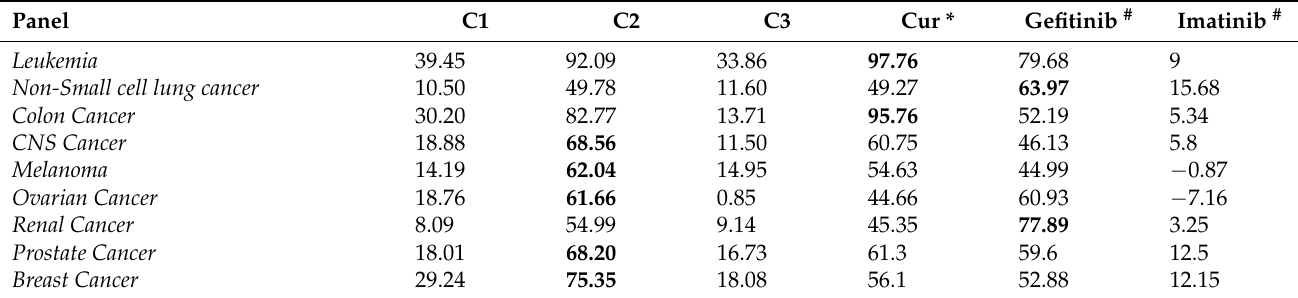
Table 2. Mean % GI of compounds C1-C3 and curcumin at 10 µ M.